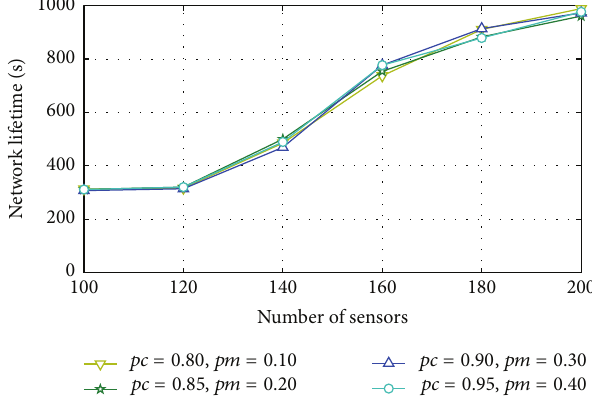
Figure 7: Network lifetimes obtained by GA-MMLT using different values of 𝑝𝑐 and 𝑝𝑚